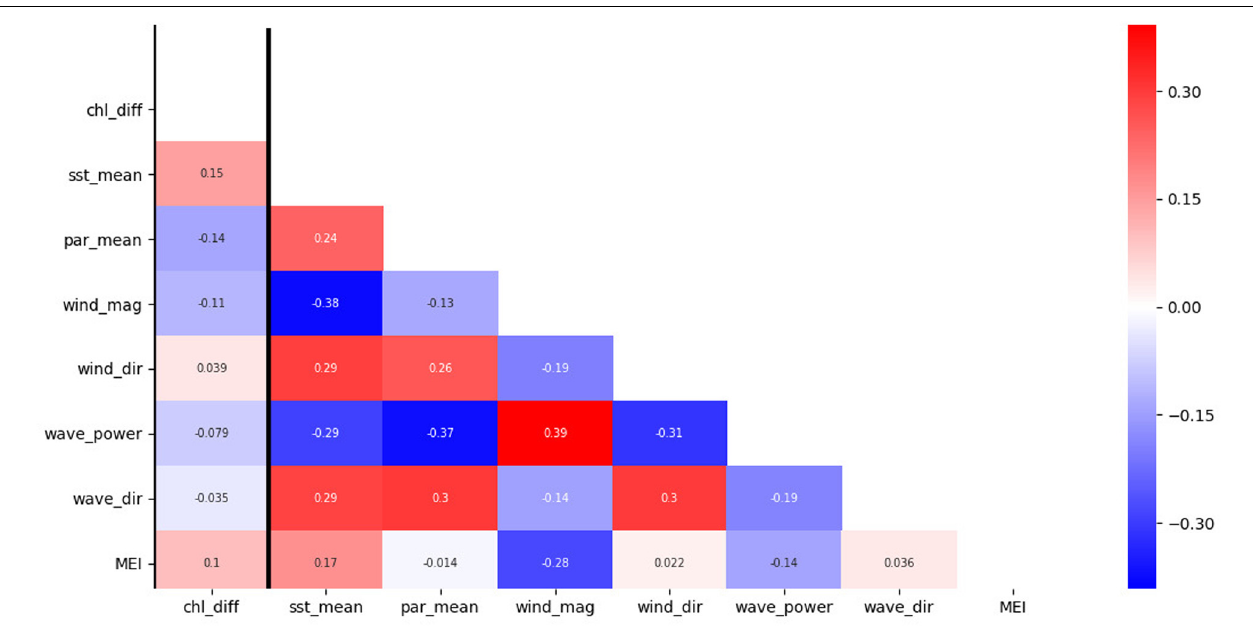
FIGURE 8 | Correlation coefficient ( r -value) heatmap from data between January 2003 to February 2019. The response variable (chl_diff) is the chlorophyll-a data differences between near Tiputa Channel and offshore. Data are 8-day averages with no lag between variables. The predictor variables are: sea surface temperature (SST) (sst_mean), photosynthetically available radiation (PAR) (par_mean), wind magnitude (wind_mag), wind direction (wind_dir), wave power (wave_power), wave direction (wave_dir), and the multivariate ENSO index (MEI). Colors indicate the correlation coefficient ( r -value). Red indicates a positive relationship between variables. Blue indicates a negative relationship between variables. The strength of color indicates the strength of the relationship.